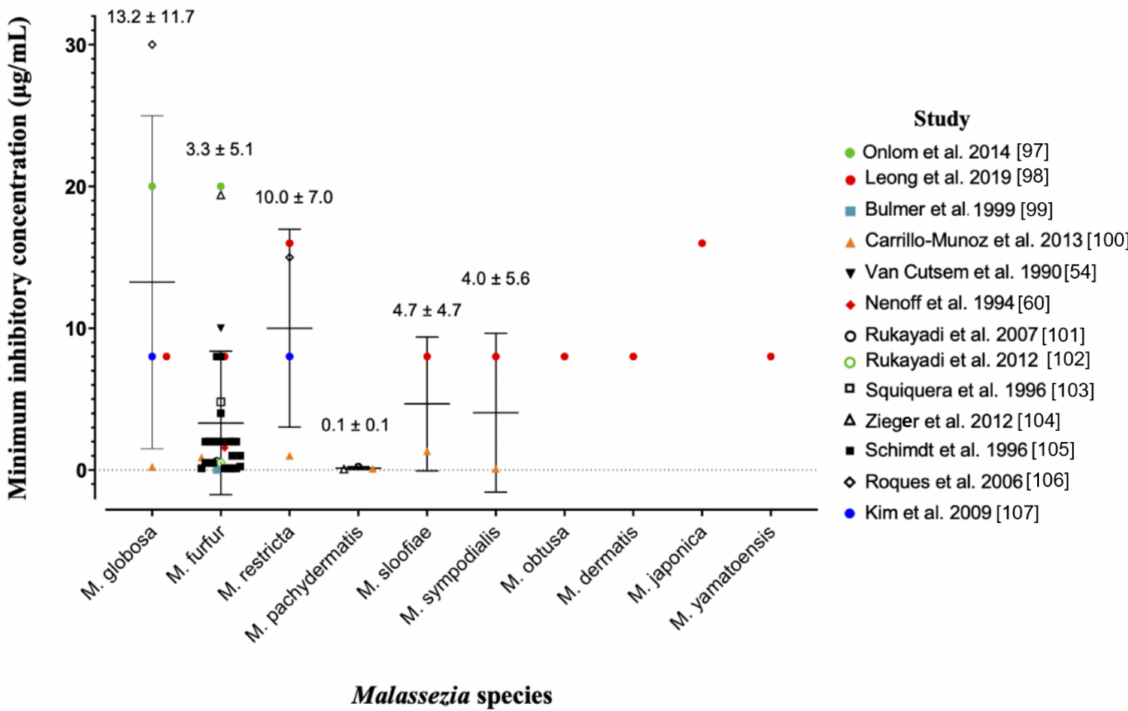
Figure 3. Pooled analysis of minimum inhibitory concentrations for zinc pyrithione against various species of Malassezia yeast. Individual studies are coded in the legend. Where the MIC of the original dataset was reported as a range, only the upper limit was included as a conservative approach to analysis. Data is presented as mean ± standard